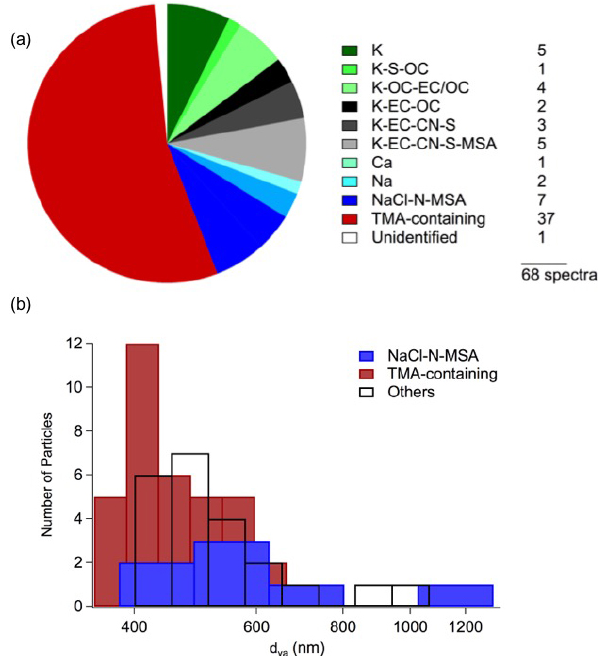
Figure 6. (a) Pie chart depicting particle types detected by the AL- ABAMA over the case study area highlighted in Fig. 2a. Particles were grouped based on the presence of marker peaks and the parti- cle group name indicates the relative abundance of the correspond- ing signals in particle spectra. A total of 68 particle spectra were obtained during the approximately 2h period. TMA-containing par- ticles are mostly internally mixed with K, S, OC, and to a lesser de- gree MSA and EC / OC. Not all TMA-containing particles included signal for MSA; 13% of all detected particles contained both TMA and MSA signals. (b) Size distributions (in terms of vacuum aero- dynamic diameter, d va ) of TMA-containing particles (red), NaCl- containing particles (blue), and all other particles classes (transpar-